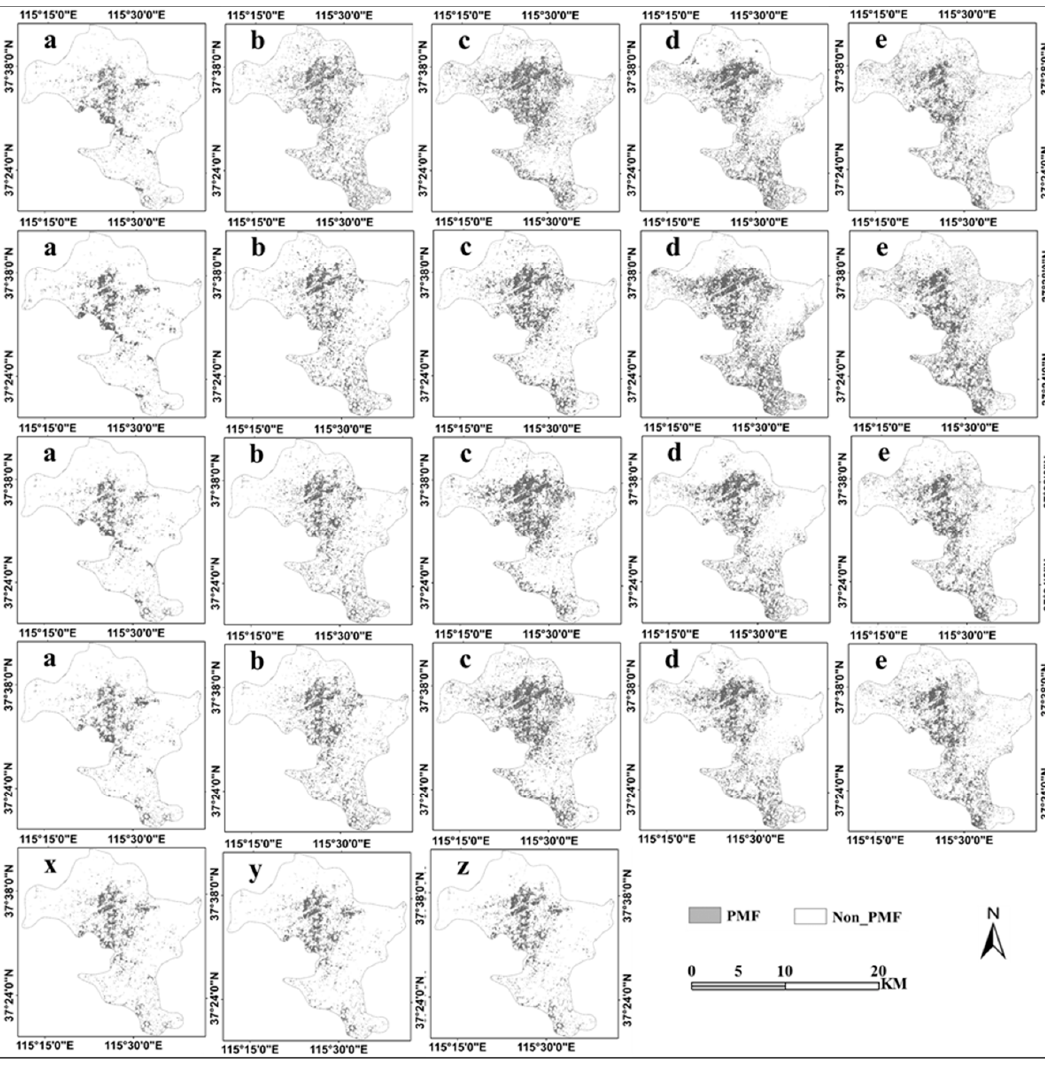
Figure 7. Spatial distribution of PMF in Jizhou using RF feature selection and RF classifier. The first line represents the results from spectral reflectance features, the second line represents the result from the textural features, the third line represents the results from the total features, the fourth line represents the results from the optimized features, and the fifth line represents the results from optimal temporal combined features. ( a ) 2015.04.16; ( b ) 2015.05.18; ( c ) 2015.06.03; ( d ) 2015.06.19; ( e ) 2015.07.05; ( x ) two-temporal combination of 2015.04.16 and 2015.05.18; ( y ) three-temporal combination of 2015.04.16, 2015.05.18, and 2015.06.03; and ( z ) four-temporal combination of 2015.04.16, 2015.05.18, 2015.06.03, and 2015.06.19.